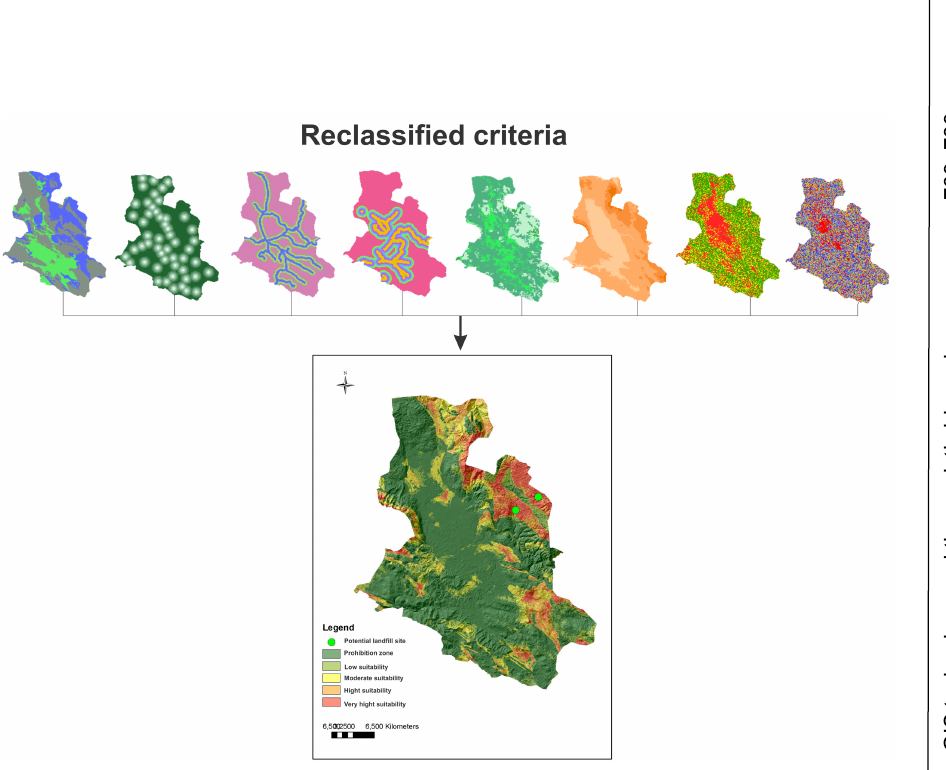
Figure 3 – Potential locations for landfills in the Municipality of Nevesinje Рис . 3 – Карта потенциальных участков для обустройства свалки , Муниципалитет